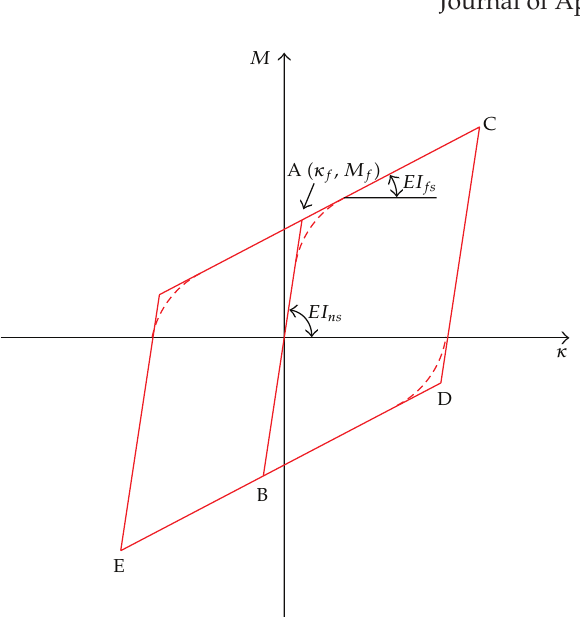
Figure 4: Schematic representation of the hysteretic response of flexible pipes under